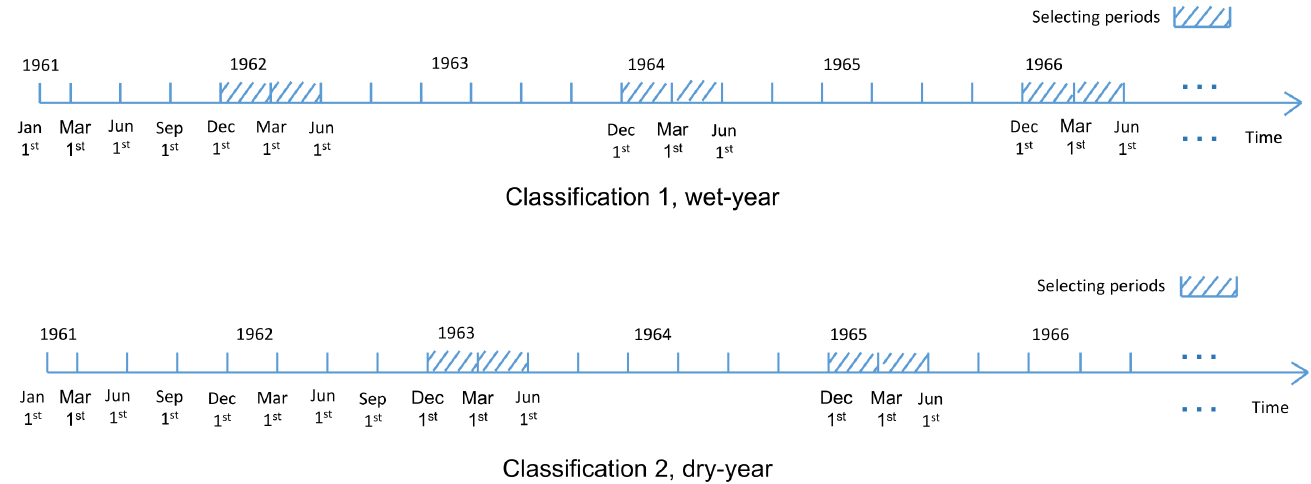
Figure 3. Ensemble classifications for runoff forecasting in wet years (odd years) and dry years (even years).